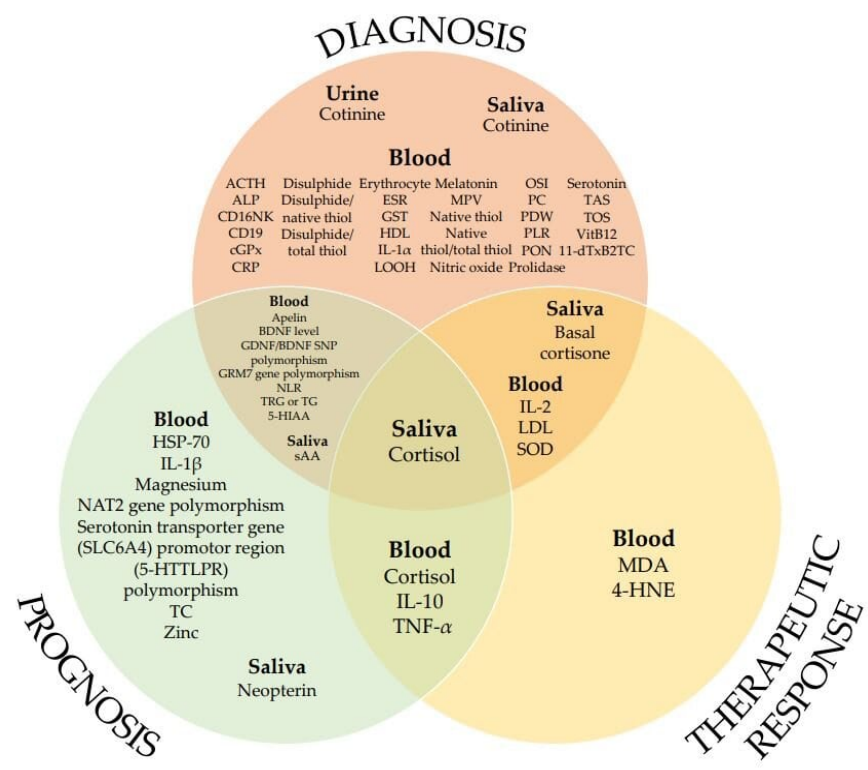
Figure 2. List of biomarkers according to potential applications (in no particular order).